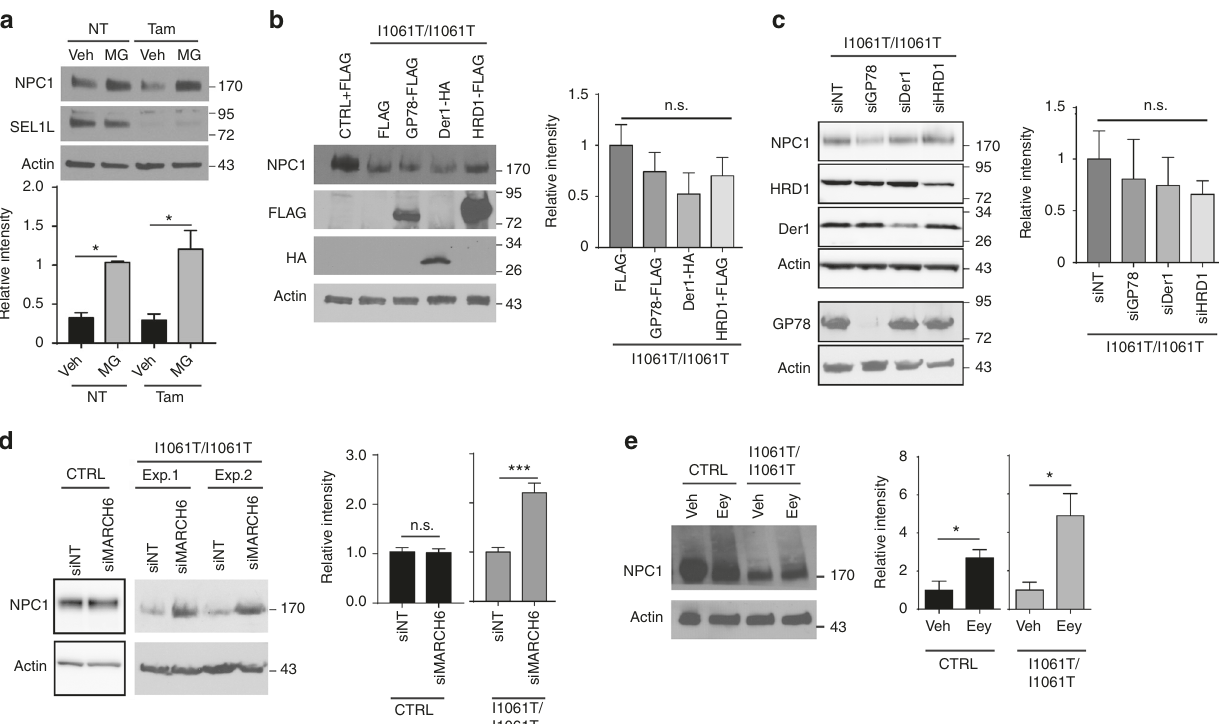
Fig. 2 I1061T NPC1 is degraded in part by MARCH6-dependent ERAD. a Tamoxifen-inducible Sel1L null mouse embryonic fi broblasts expressing WT NPC1 were treated with vehicle (NT) or 200 nM tamoxifen (Tam) for 48 h. Cells were also treated with vehicle (Veh) or 10 µ M MG132 (MG) during the last 24 h to determine if Sel-1L de fi ciency alters the pool of WT NPC1 traf fi cking to the proteasome. NPC1 protein level quanti fi ed below. b Over-expression of FLAG, GP78-FLAG, Der1-HA, and HRD1-FLAG in I1061T NPC1 fi broblasts. Cells were transfected at t = 0 and t = 24 h and lysates collected at 48 h. Transgene expression con fi rmed using antibodies against FLAG and HA. NPC1 quanti fi ed at right, normalized to I1061T NPC1 fi broblasts transfected with FLAG. c I1061T NPC1 fi broblasts were treated with the following siRNAs: non-targeting (NT), GP78, Der1, and HRD1 at t = 0 and t = 24 h. Lysates were collected at 48 h. NPC1 quanti fi ed at right, normalized to I1061T NPC1 fi broblasts transfected with NT siRNA. d , e CTRL and I1061T NPC1 fi broblasts were treated with d non-targeting or MARCH6 siRNA (shown are two independent experiments for I1061T), e vehicle (Veh) or 10 μ M eeyarestatin I (Eey). Lysates were blotted for NPC1 (quanti fi ed at right). Data are mean ± s.e.m. a – e N = 3 – 4, b , c N = 5 – 6, d N = 4 – 6. a – c One-way ANOVA with Tukey ’ s posthoc